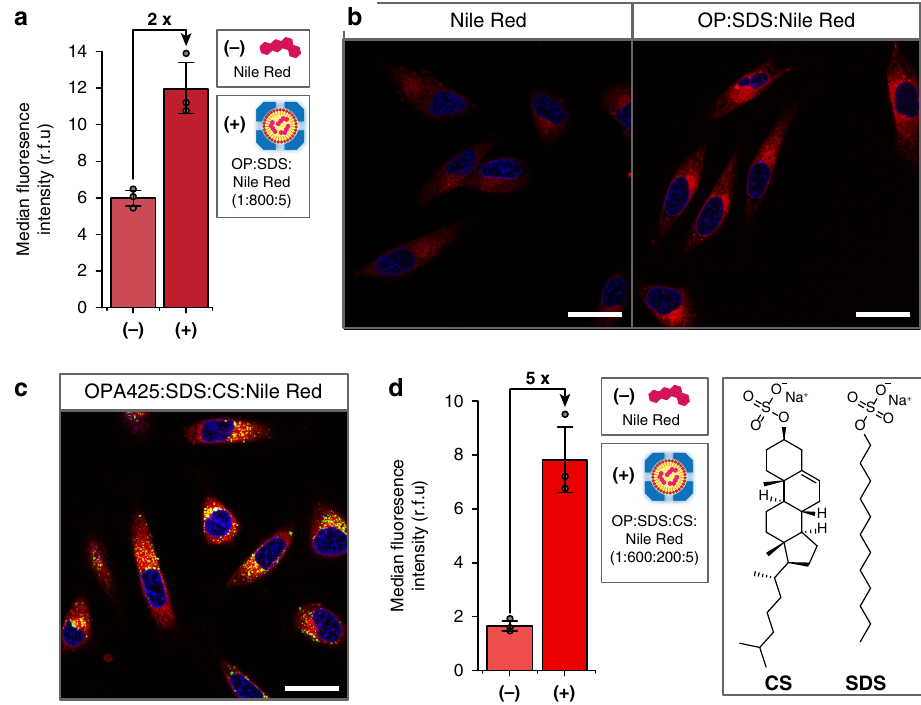
Fig. 4 Intracellular delivery of fl uorescent cargo. a Flow cytometry dataset for HeLa cells treated with either free Nile Red or Nile Red packaged in OP:SDS complexes, with fi ve Nile Red molecules per capsid ( n = 3, error bars: standard deviation). b Confocal fl uorescence microscopy of HeLa cells treated with Nile Red as free molecules (left panel) or packaged in OP:SDS complexes (right panel). Blue: Hoechst 33342 (nucleus), red: Nile Red, scale bars are 30 μ m. c Confocal fl uorescence microscopy of HeLa cells treated with OP:SDS:CS:Nile Red complexes where OP capsids are labeled with Atto425. Blue: Hoechst 33342 (nucleus), red: Nile Red, green: Atto425 (OP), scale bar is 30 μ m. The individual channels can be found in Supplementary Fig. 8. d Flow cytometry comparison of HeLa cells treated with free Nile Red ( − ) or Nile Red packaged in OP:SDS:CS complexes ( + ), where the ratio of OP:SDS:CS is 1:600:200 and there are 5 molecules of Nile Red per capsid ( n = 3, error bars: standard deviation). Source data are provided as a Source Data fi